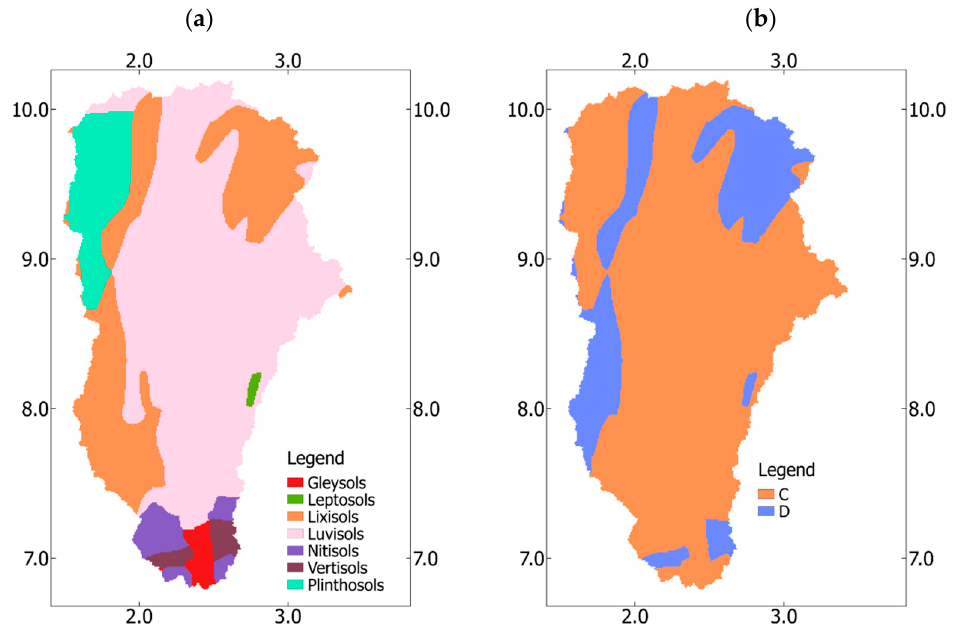
Figure 2. Soil types ( a ) and hydrological soil groups ( b ) in Ouémé catchment.